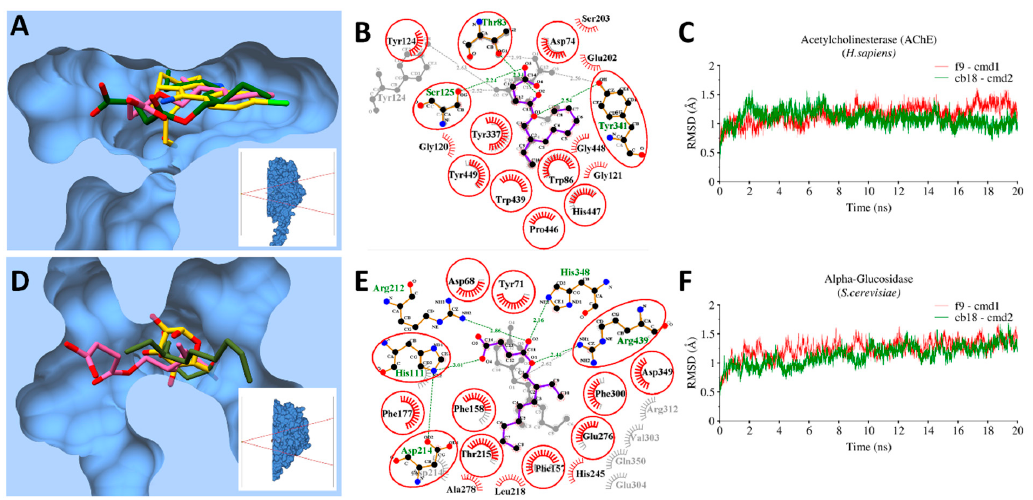
Figure 4. Molecular interactions and MD simulations of CB18 and F9 against AChE and S. cerevisiae - α -glucosidase. ( A ) The molecular surface representation of acetylcholinesterase (AChE) with bound co-crystalized ligand (gold), CB18 (green) and F9 (pink) superimposed together; ( B ) 2D-interaction plots with AChE after MD-simulations, hydrophobic interacting residues are labeled black with spiked red arc, while those interacting through H-bonds are labelled green with distance in angstrom. Conserved residues are marked with red circles; ( C ) RMSD trajectory plots of AChE with bound CB18 (green) and F9 (red) over a period of 20 ns. The same representation of corresponding S. cerevisiae - α -glucosidase with bound CB18 and F9 are displayed in ( D – F ) respectively in the same color schemes.